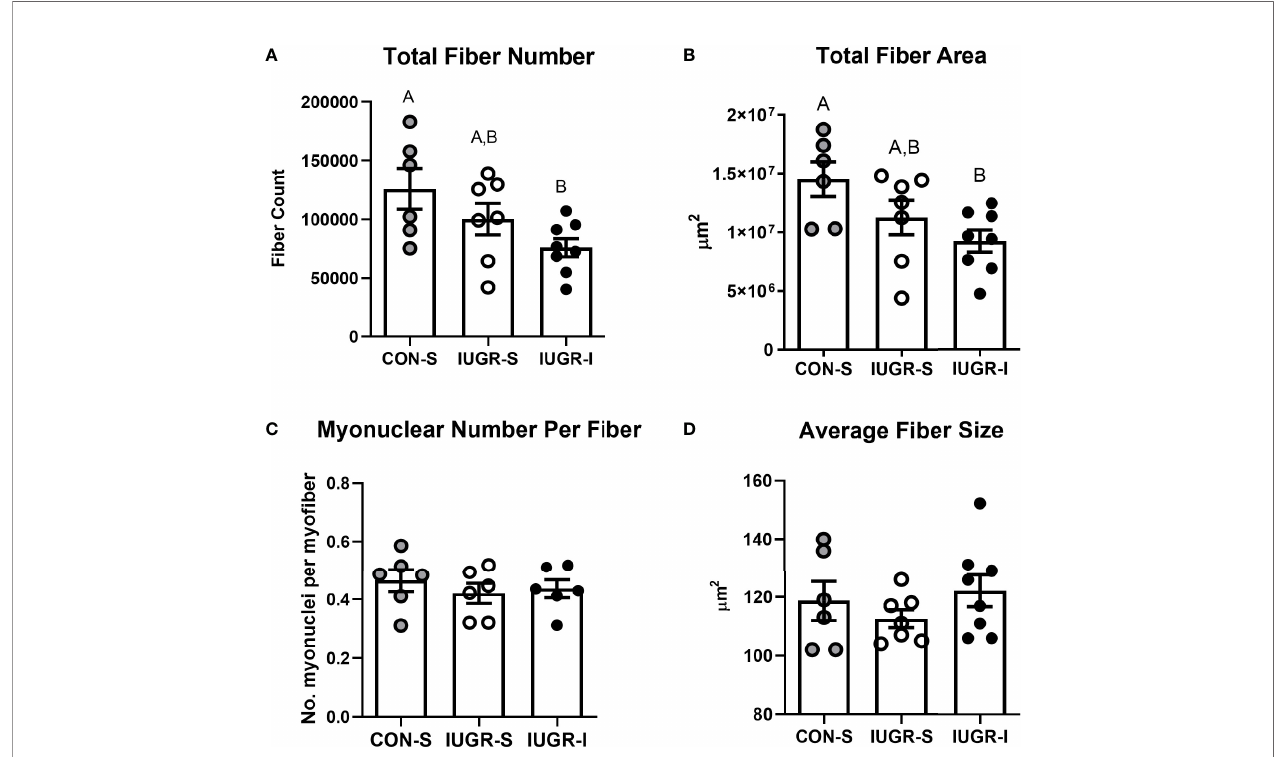
FIGURE 6 | IUGR-I fetuses have lower fi ber number and fi ber area in the fl exor digitorum super fi cialis (FDS) muscle compared to CON-S fetuses. (A) Total fi ber number, (B) total fi ber area, (C) myonuclear number per fi ber, and (D) average fi ber size. The IUGR-I fetuses have 40% lower total fi ber number when compared to CON-S (P=0.040, one-way ANOVA). In addition, the IUGR-I fetuses have 36% less total fi ber area when compared to CON-S (P=0.031, one-way ANOVA). However, the overall size of individual fi bers and the number of myonuclei per fi ber were not different among the groups. CON-S (grey circle, n=6), IUGR-S (white circle, n=6-7), and IUGR-I (black circle, n=6-8). Values are mean ± SEM. Statistical signi fi cance was designated by different alphabetical letters at P ≤ 0.05 by one-way ANOVA and Fisher ’ s least signi fi cant difference post hoc test.